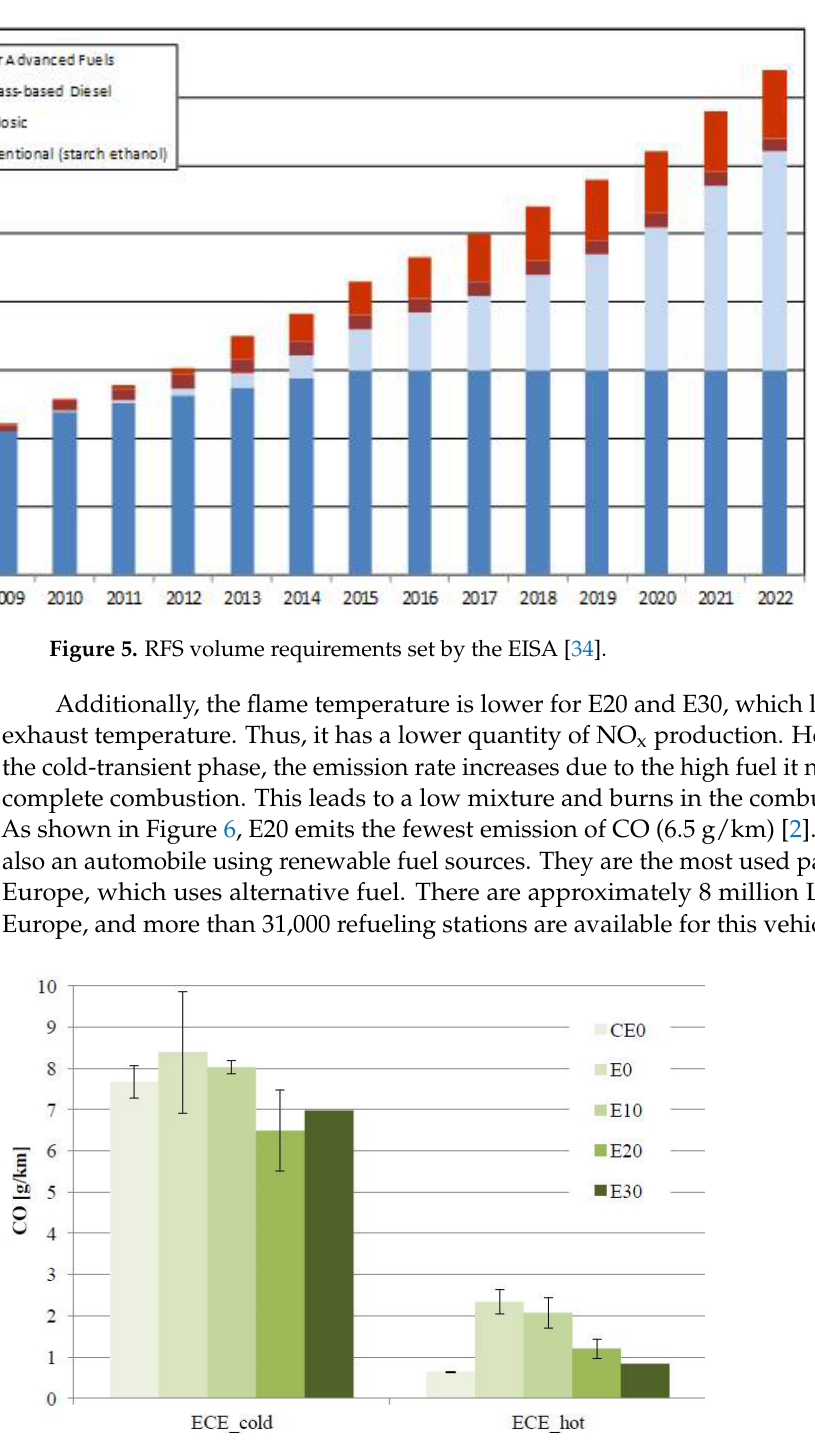
Figure 6. CO emission for various fuel source during cold and hot transient phase [2].